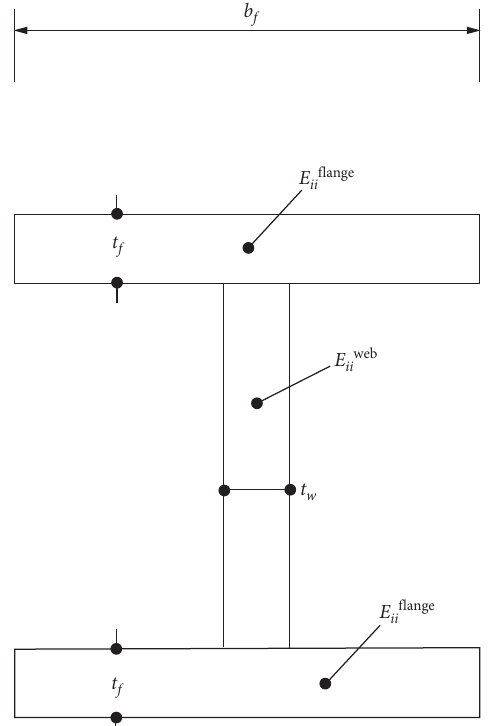
Figure 11: Typical details of beam specimens.